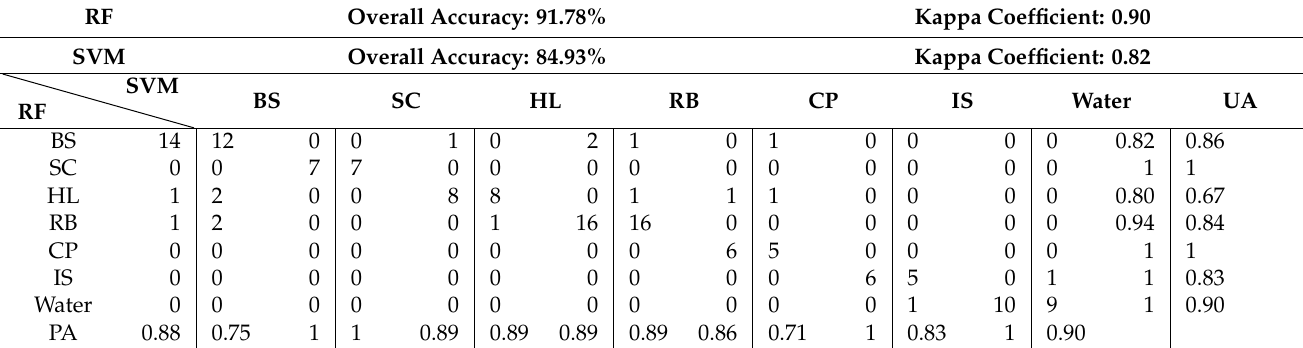
Table 5. Confusion matrix for mangrove classification with GPS